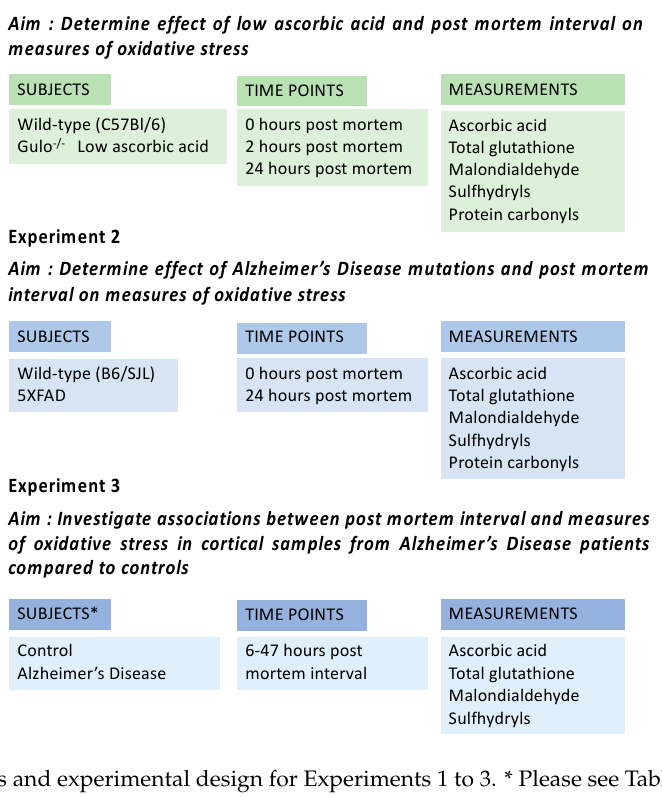
Figure 1. Subjects and experimental design for Experiments 1 to 3. * Please see Table 1 for details of human subjects in Experiment 3.